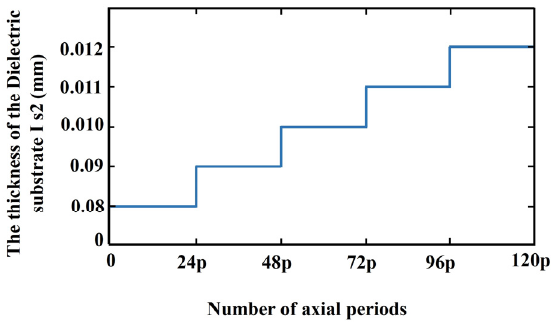
Figure 4. The thickness of the dielectric rod І (s2) as a function of the axial period.